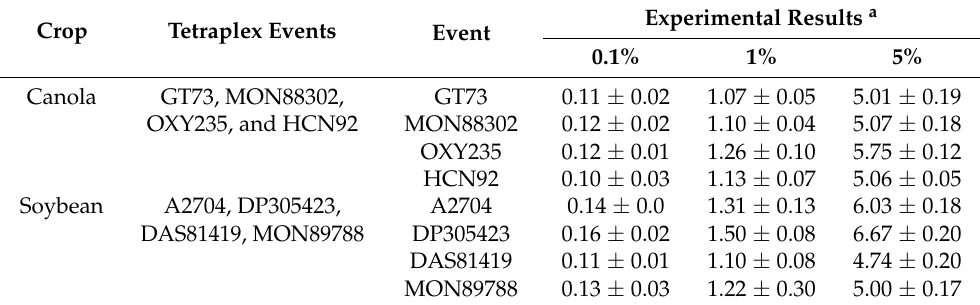
Table 4. Experimental results for the tetraplex ddPCR assays for GM canola and soybean events.